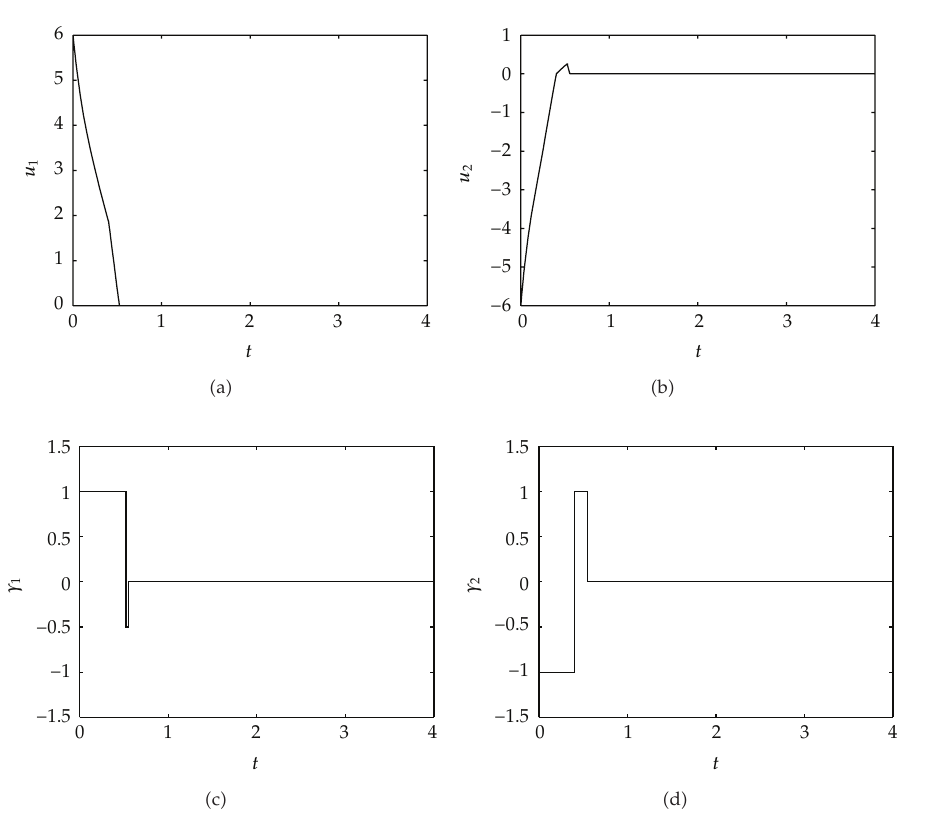
Figure 1: Transient behavior of (cid:5) u 1 ,u 2 (cid:6) and (cid:5) γ 1 ,γ 2 (cid:6) for I (cid:7) (cid:5) 0 , 0 (cid:6) T , u 0 (cid:7) (cid:5) 6 , − 6 (cid:6) T